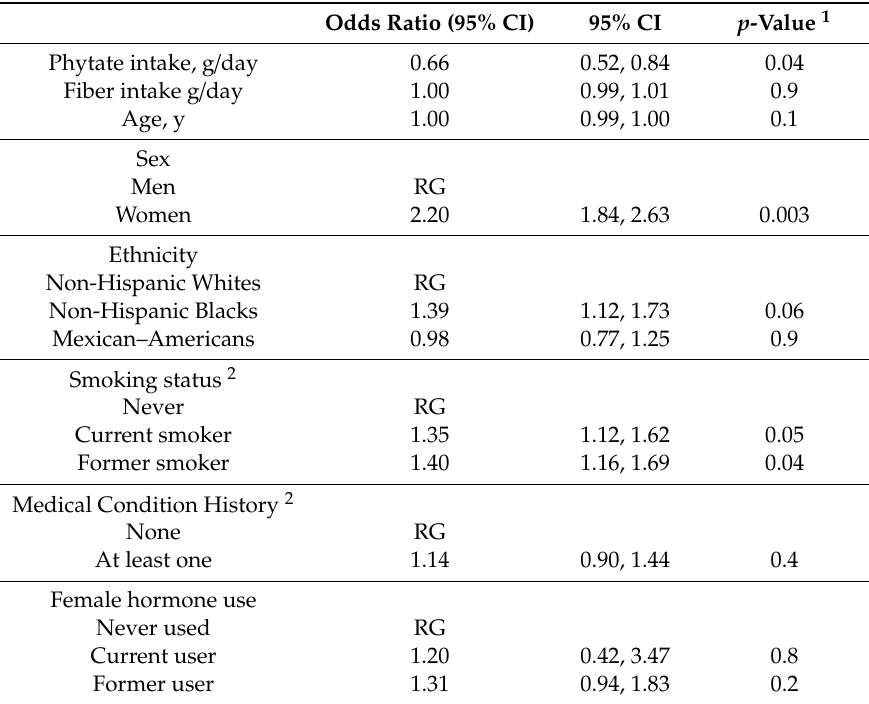
Table 4. Predictors of elevated CRP levels (CRP > 3 mg / L) among subjects ≥ 20 years with overweight or obesity as per the NHANES of 2009 /